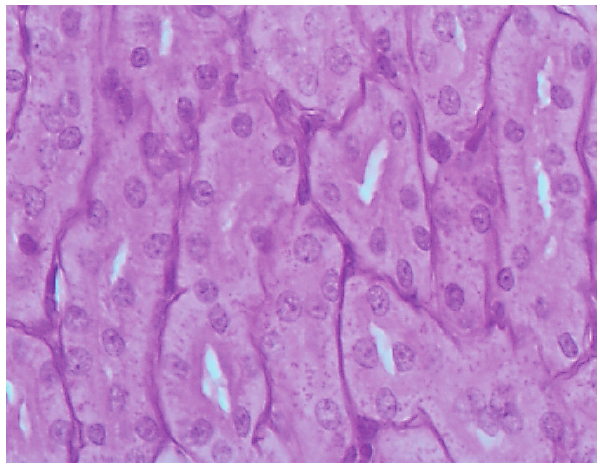
Figure 2. Kidney of a control rat (proximal convoluted tubules with an intact brush border). Periodic Acid Shiff (PAS) stain, magnification ×400.